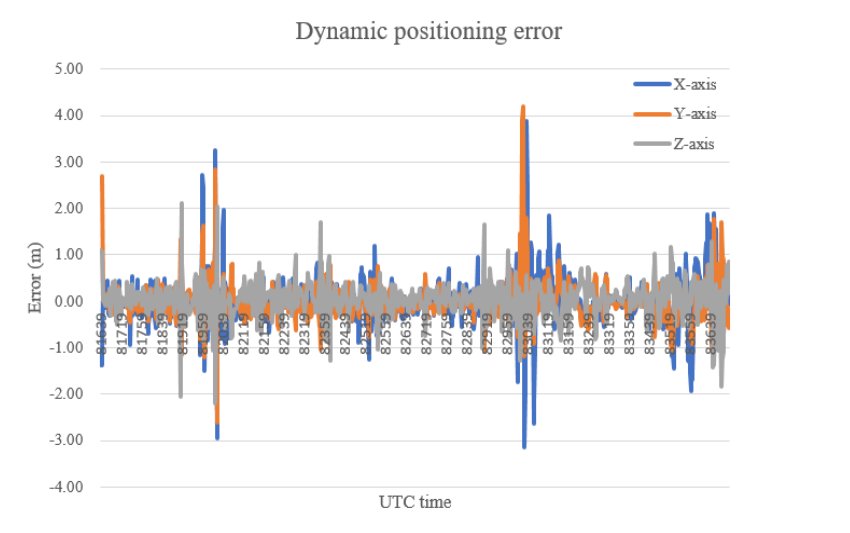
Figure 15. The corrected dynamic positioning